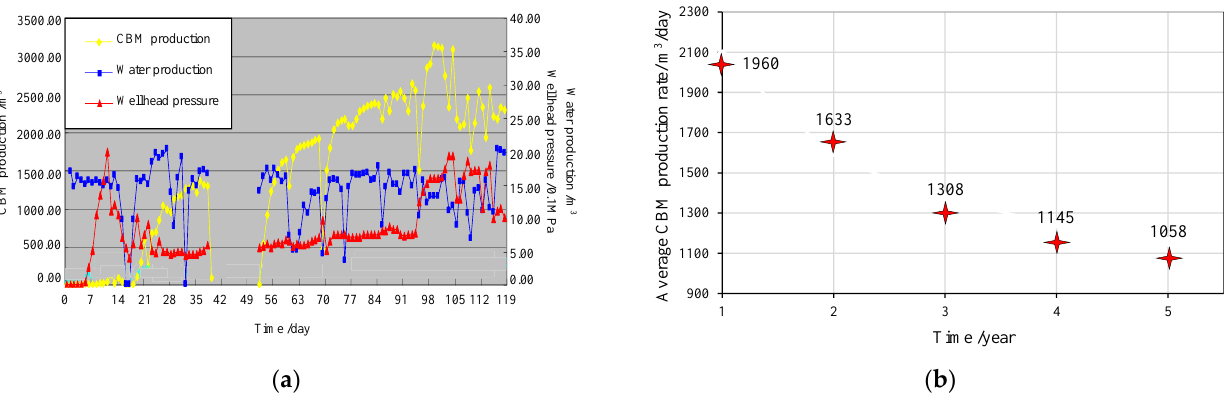
Figure 4. The in situ curve of CBM production of well #BLCX-1005. ( a ) CBM/water production and wellhead pressure within 120 days, and ( b ) average CBM production rate within different years.